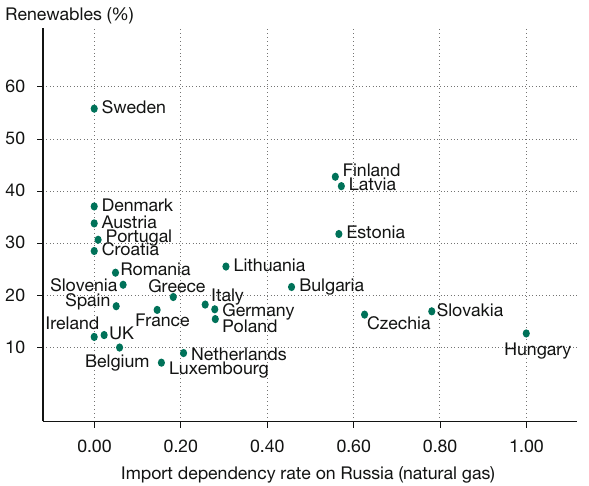
Exposure to disruptions in GVCs